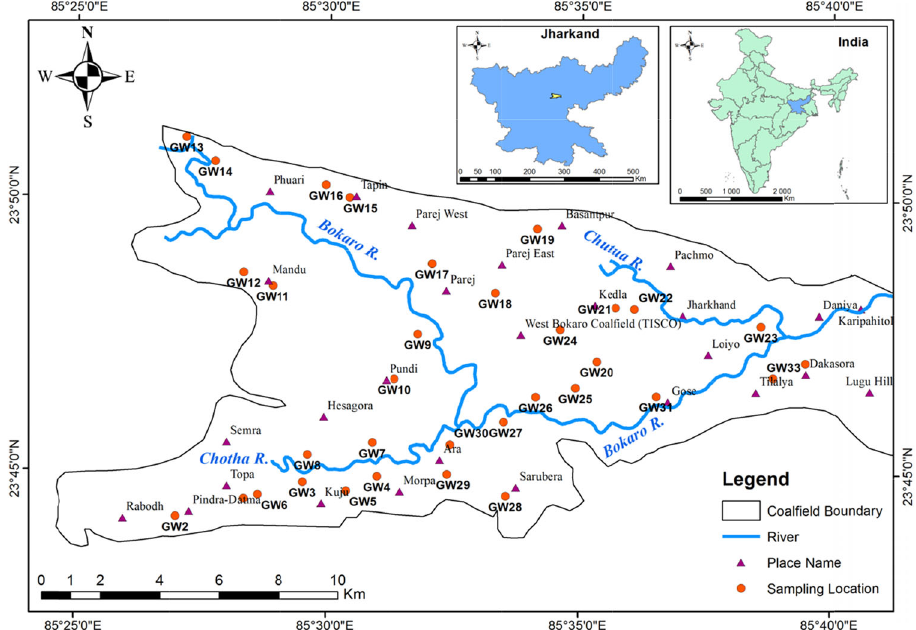
Fig. 1 Sampling location map of the West Bokaro coalfield